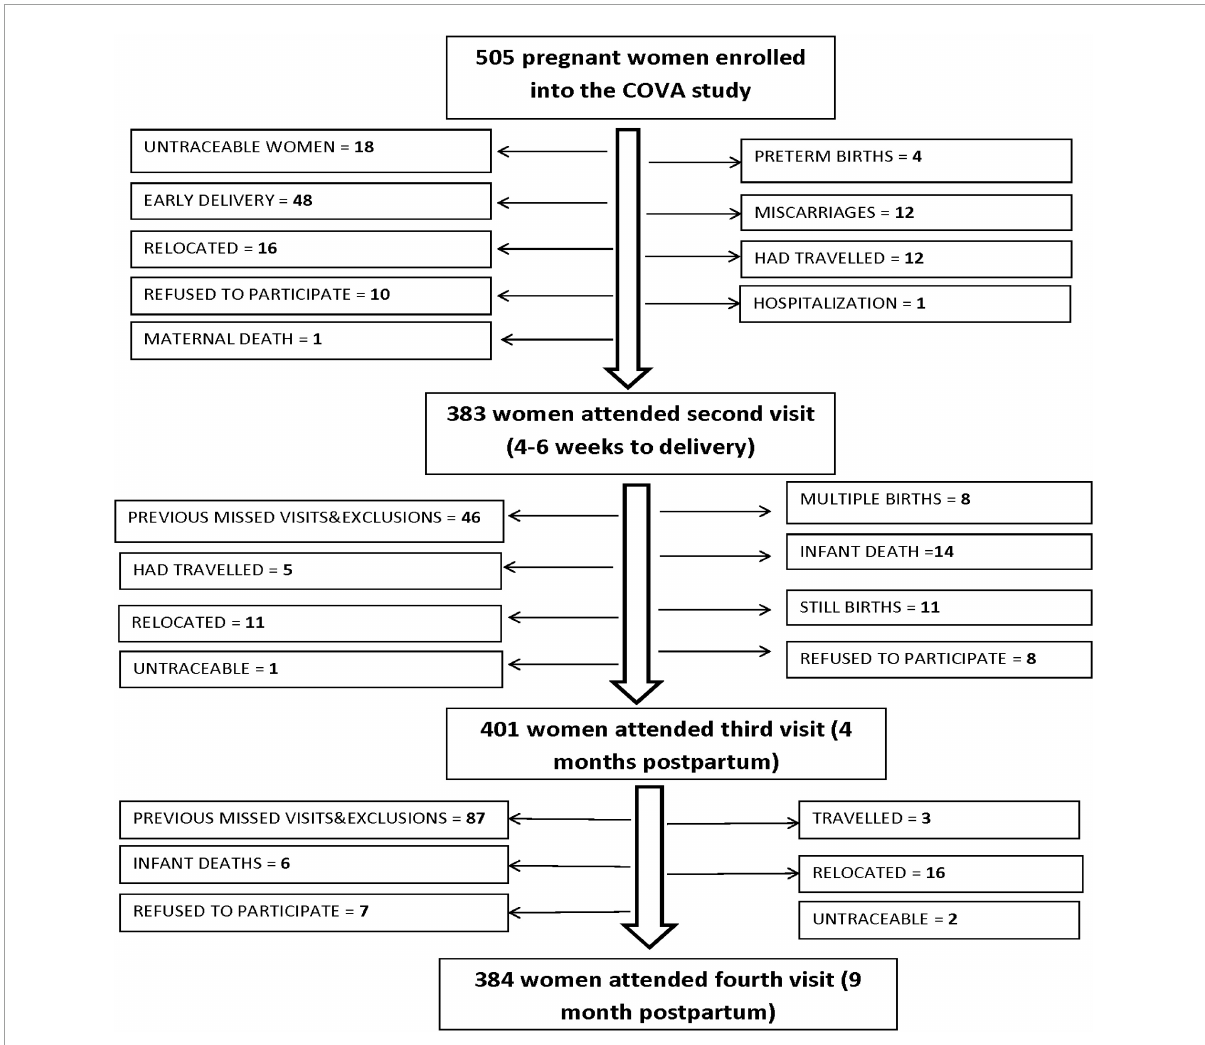
FIGURE1 Numbers and reasons for loss to follow up for the 505 women enrolled in the cohort study of vitamin A (COVA) in western Kenya.